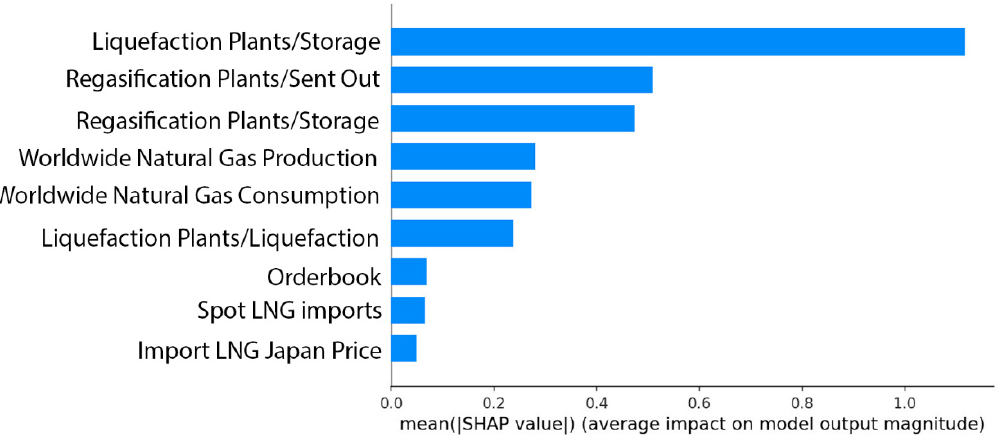
Figure 6. SHAP summary plot for LNG 145K CBM spot rate: 6 months of GRNN model.